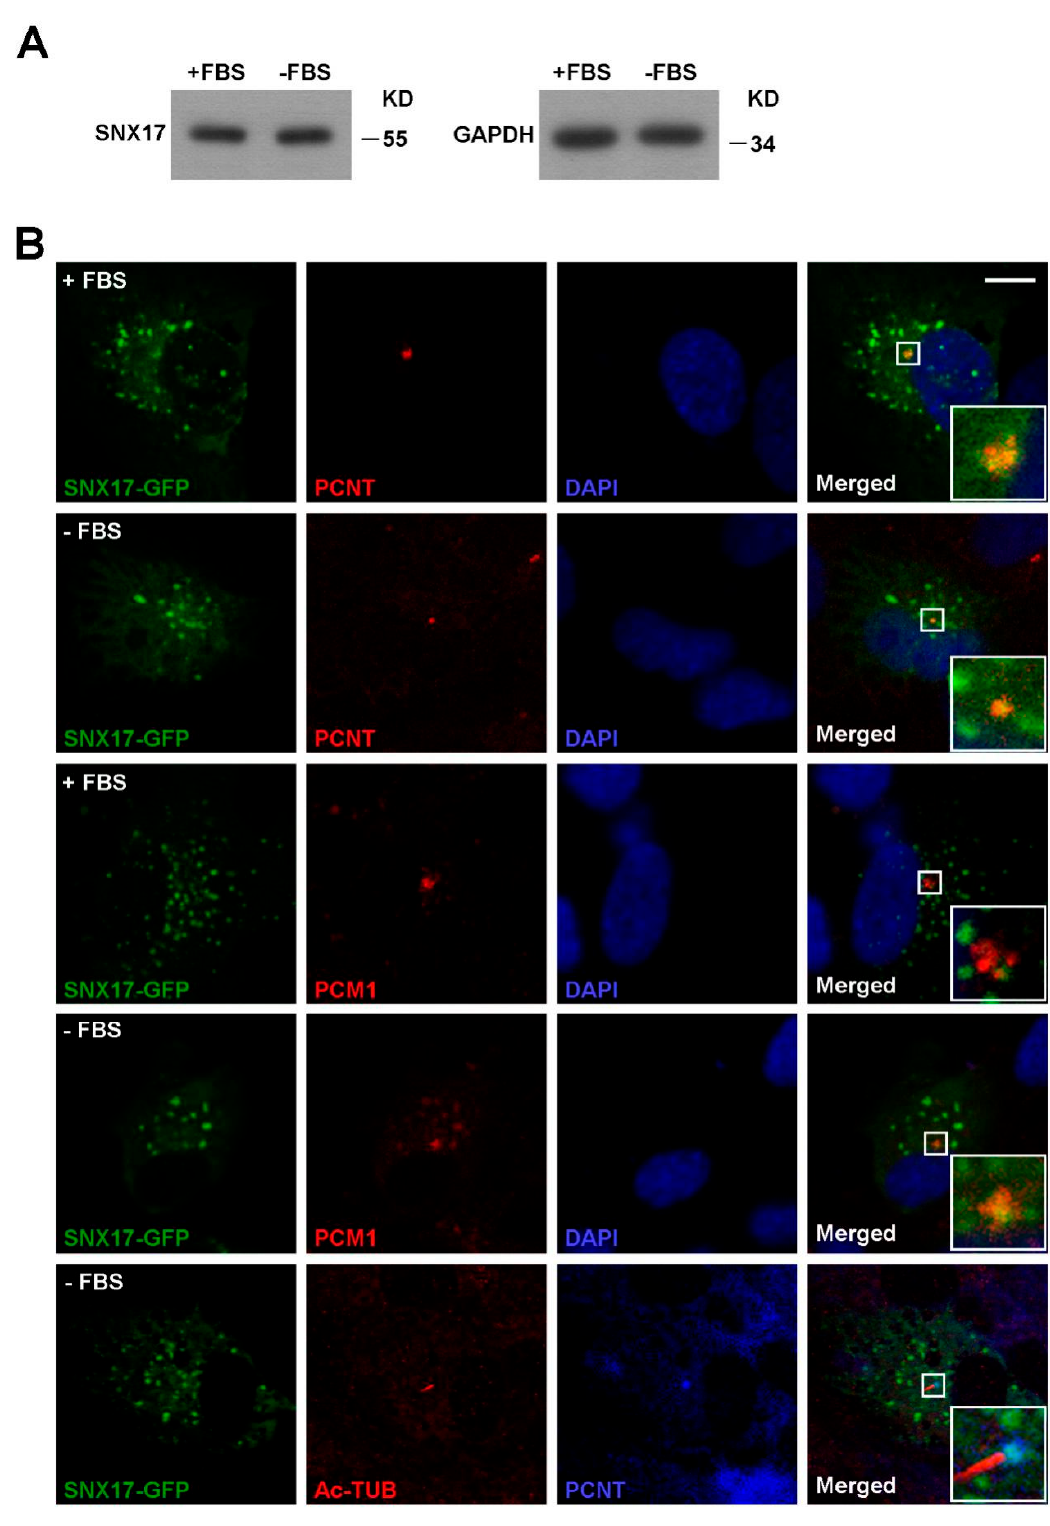
Figure 2. Homeostasis and subcellular distribution of SNX17. ( A ) Western blot analysis for total SNX17 protein level in the presence or absence (48 h) of serum. GAPDH was loading control. ( B ) Distribution of SNX17-GFP in RPE1 cells. Cells were transfected with a plasmid-encoding SNX17-GFP, and co-localization of SNX17 with endogenous centrosome marker PCNT or centriolar satellite marker pericentriolar material 1 (PCM1) was determined by immunofluorescence staining. AC-Tub labels the mature cilium. Scale bar, 10 µm.